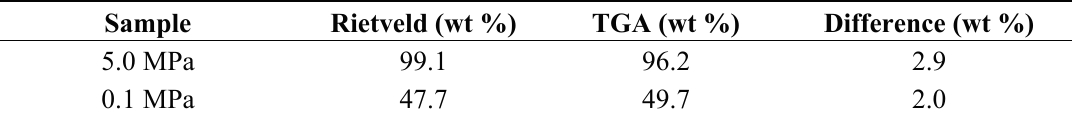
Table 1. Validation of XRD Rietveld refinements by